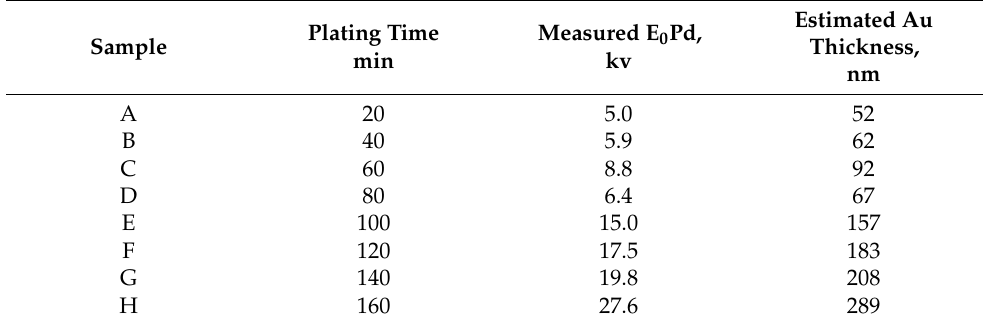
Figure 1. Linear fitting of the five measurable Au strip reference E 0 Pd measurements (red circles) and estimation of Au thickness based on measured E 0 Pd values for samples A–H (blue triangles). Table 4. E 0 Pd and estimated Au thickness for the samples A–H.